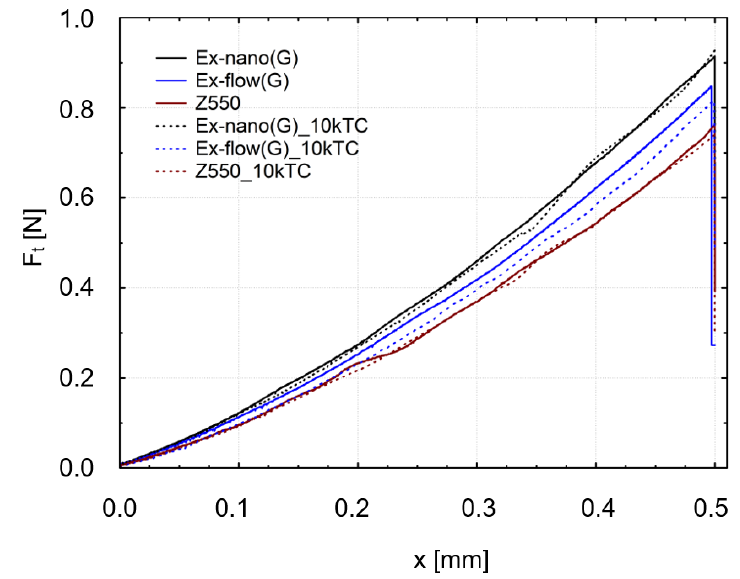
Figure 4. Mean curves of the friction force (F t ) as a function of the indenter position (x) (10,000 thermal cycles (TCs)).